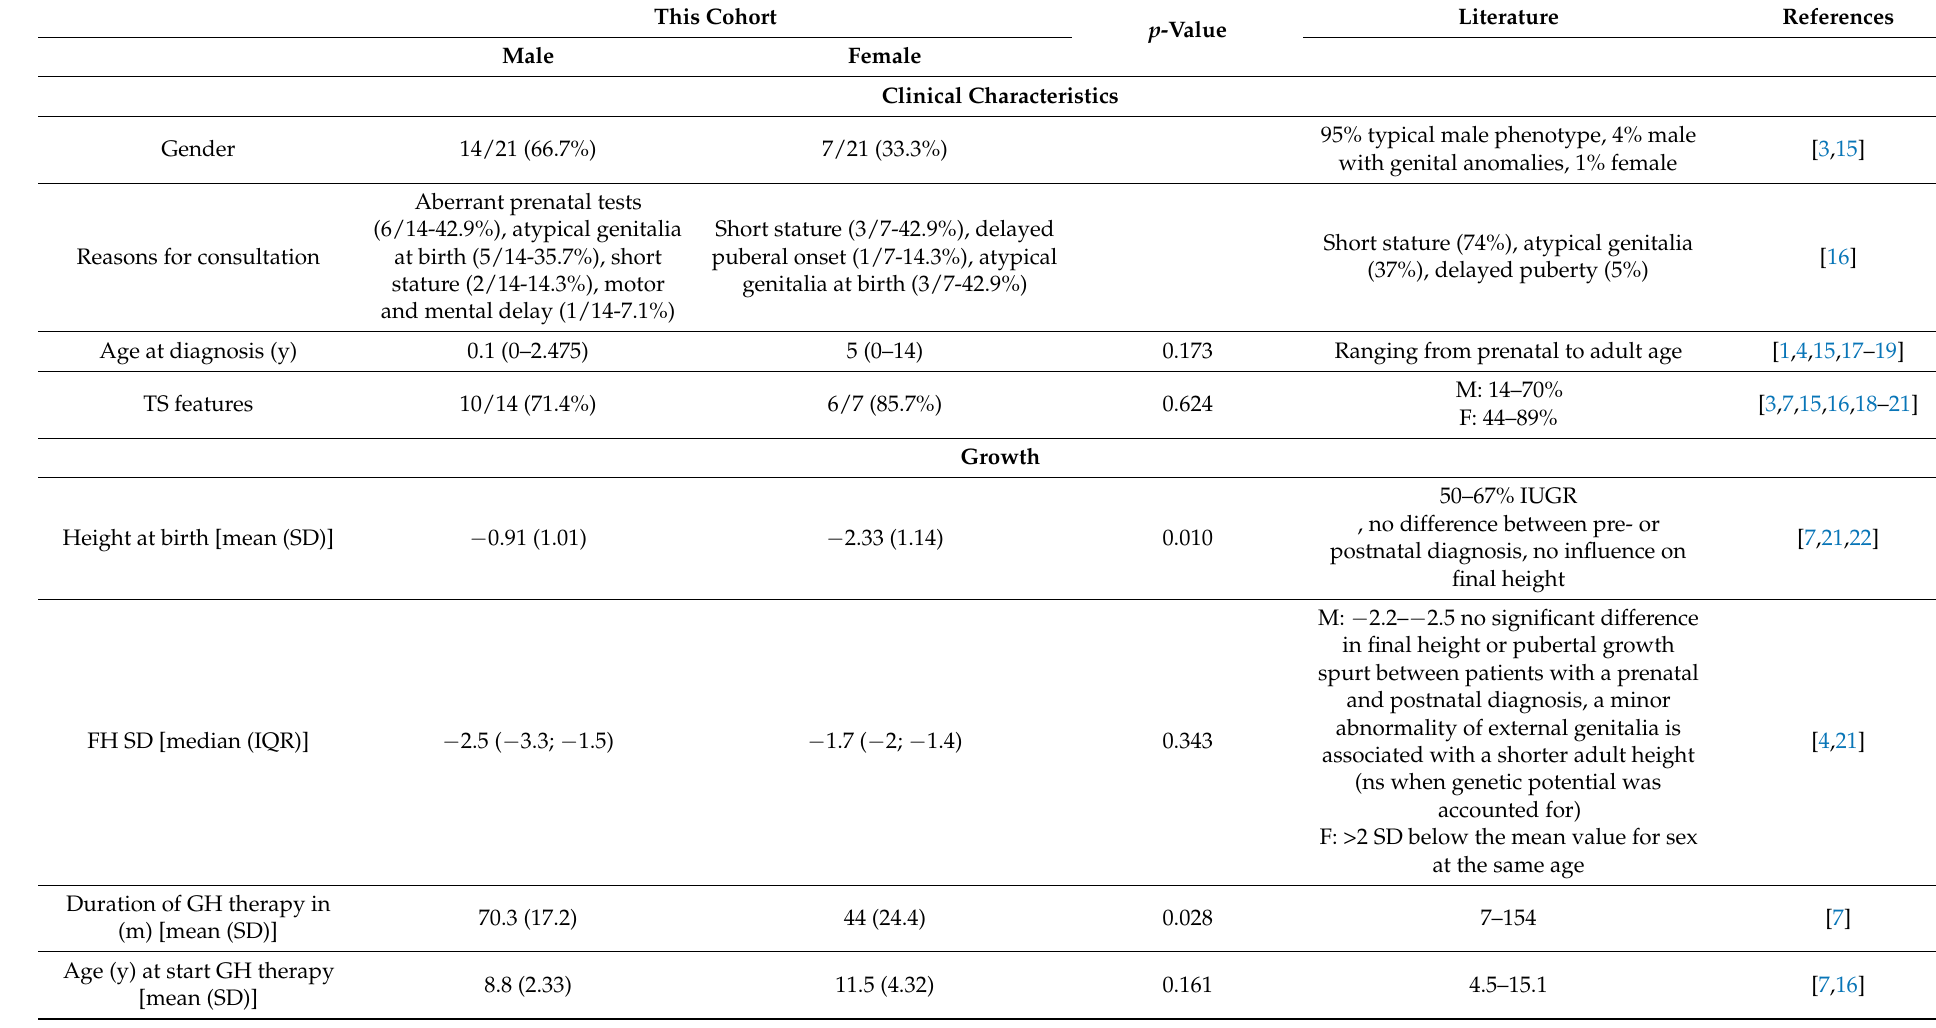
Table 3. Comparison of findings in girls and boys of this cohort with literature